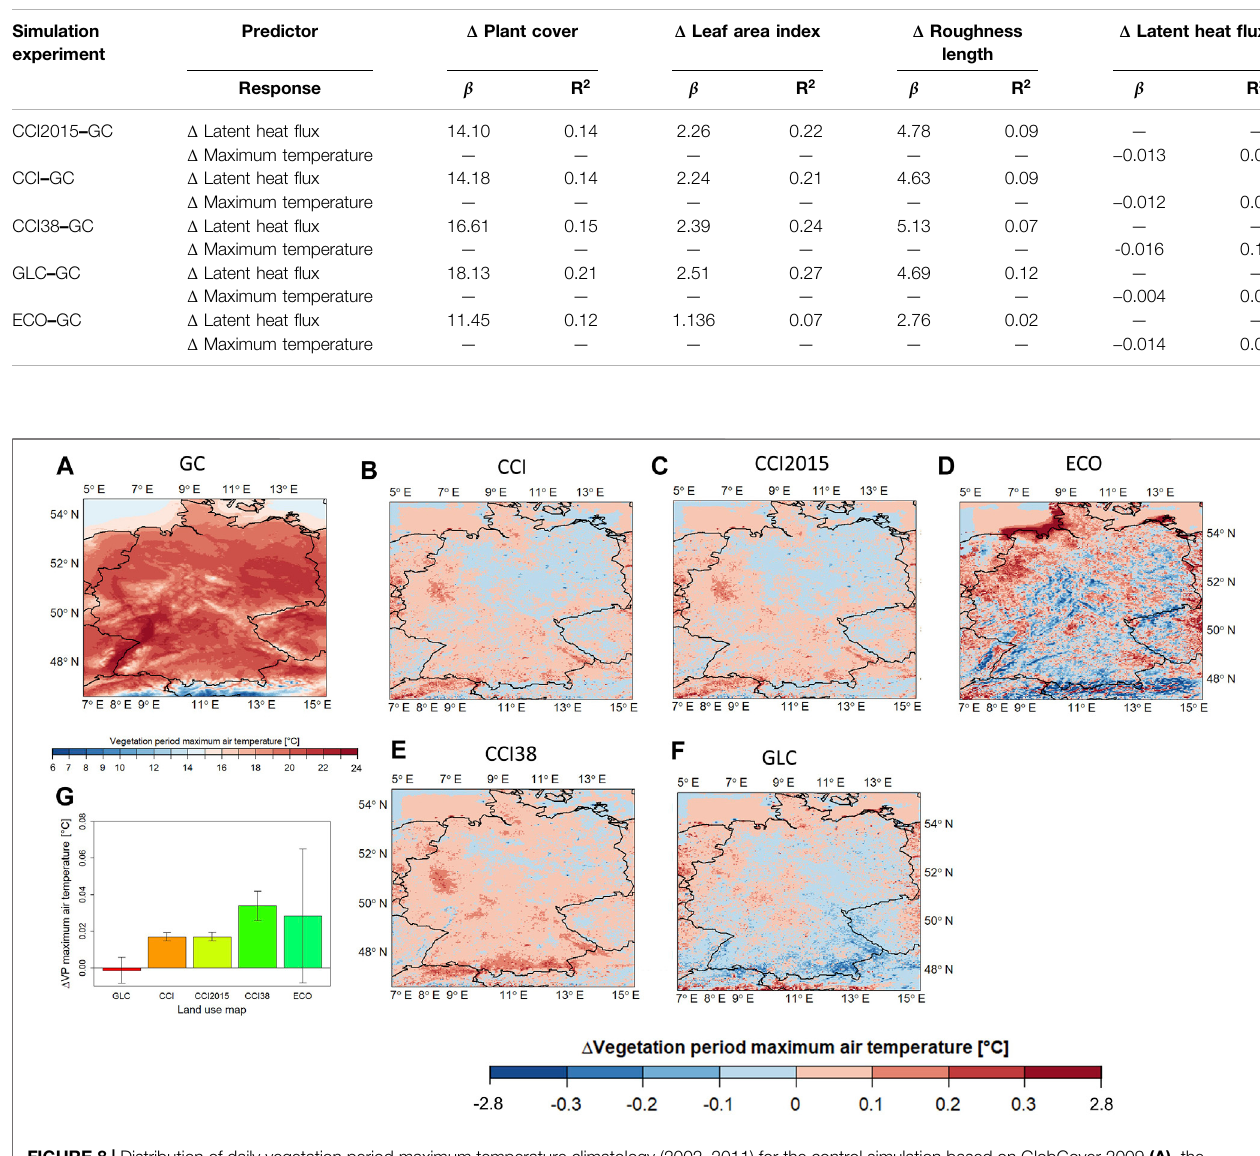
Frontiers in Earth Science |